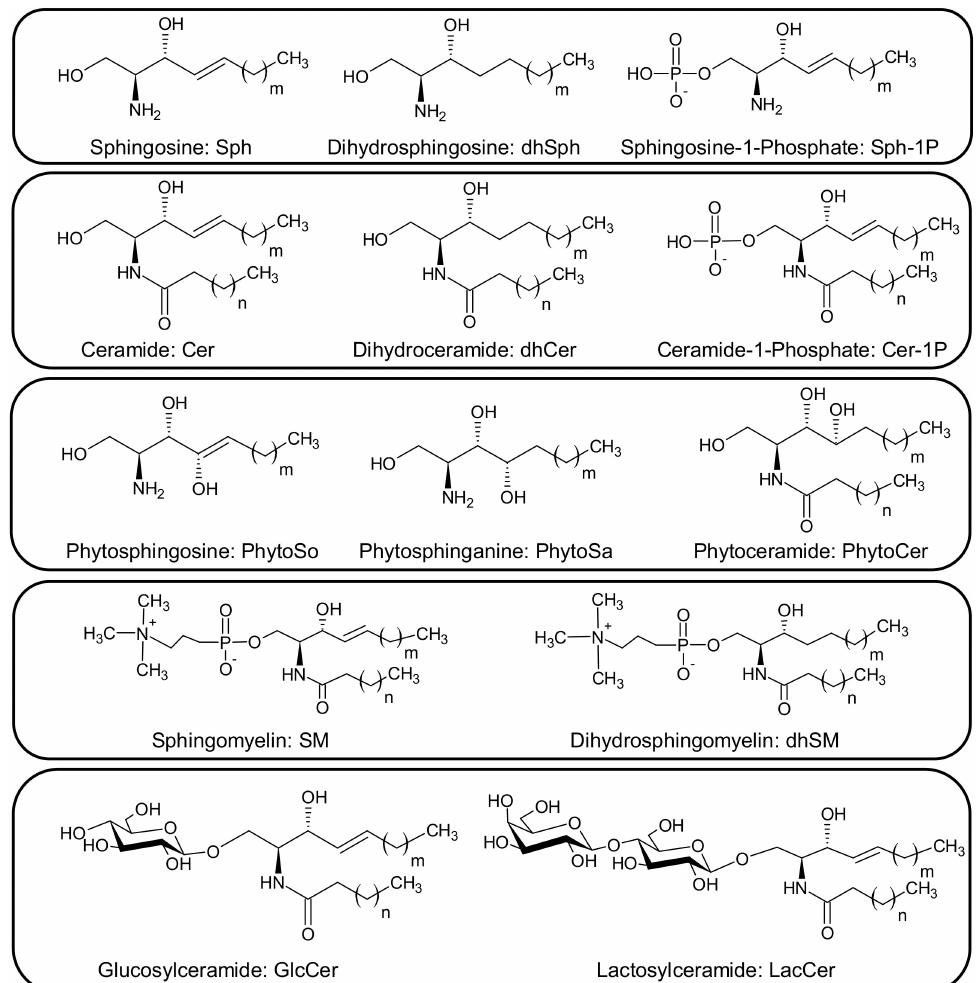
Figure 1. General structures, nomenclatures, and abbreviations for SPLs. m , carbon number of the sphingoid base backbone; n , carbon number of the fatty acid